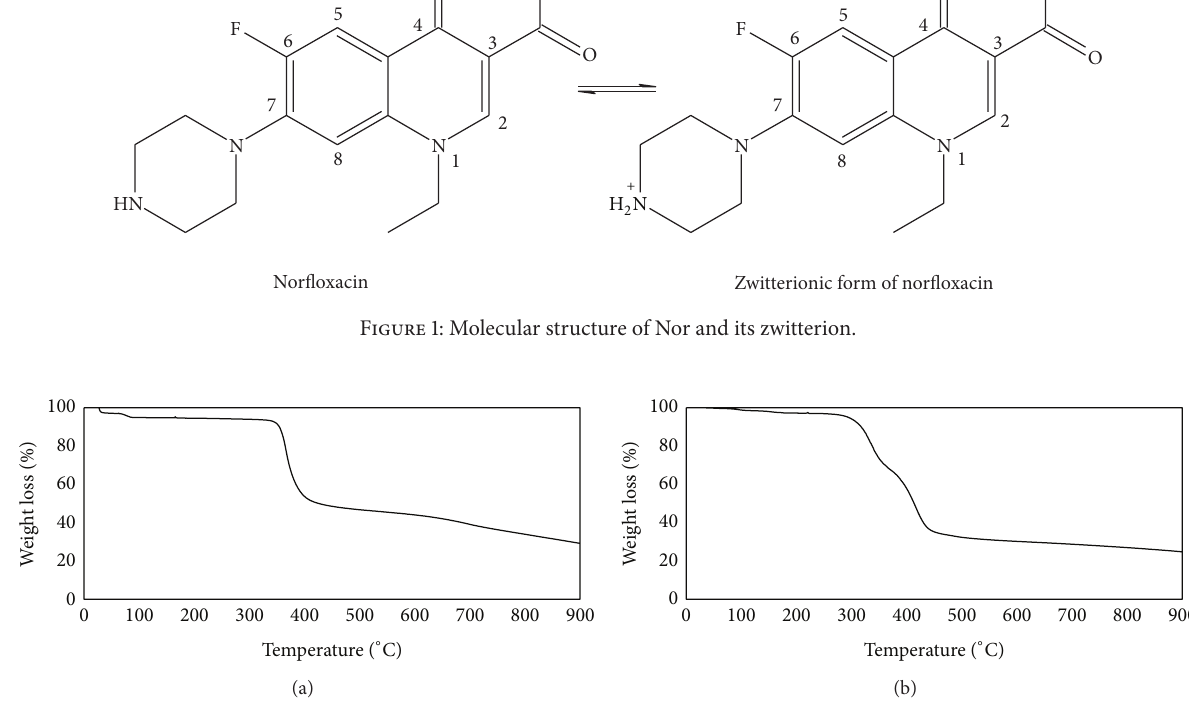
Figure 2: TGA pattern of (a) Nor and (b) [Cr(Nor)(Bipy)Cl 2 ]Cl ⋅ 2CH 3